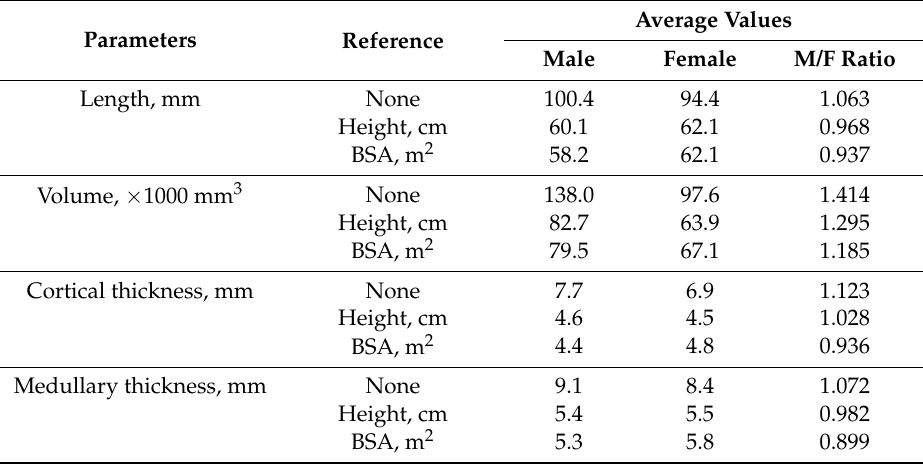
Table 2. Kidney morphological parameters with reference to body size.